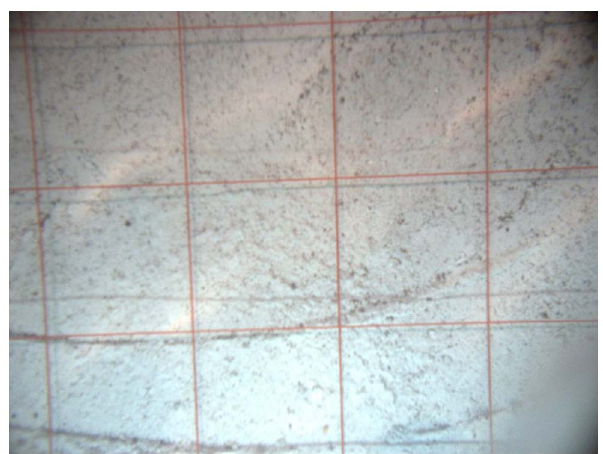
Figure 3. A checkered frame photographed underwater with the AUV camera for lens distortion correction where each square represents 15 6 15 cm.